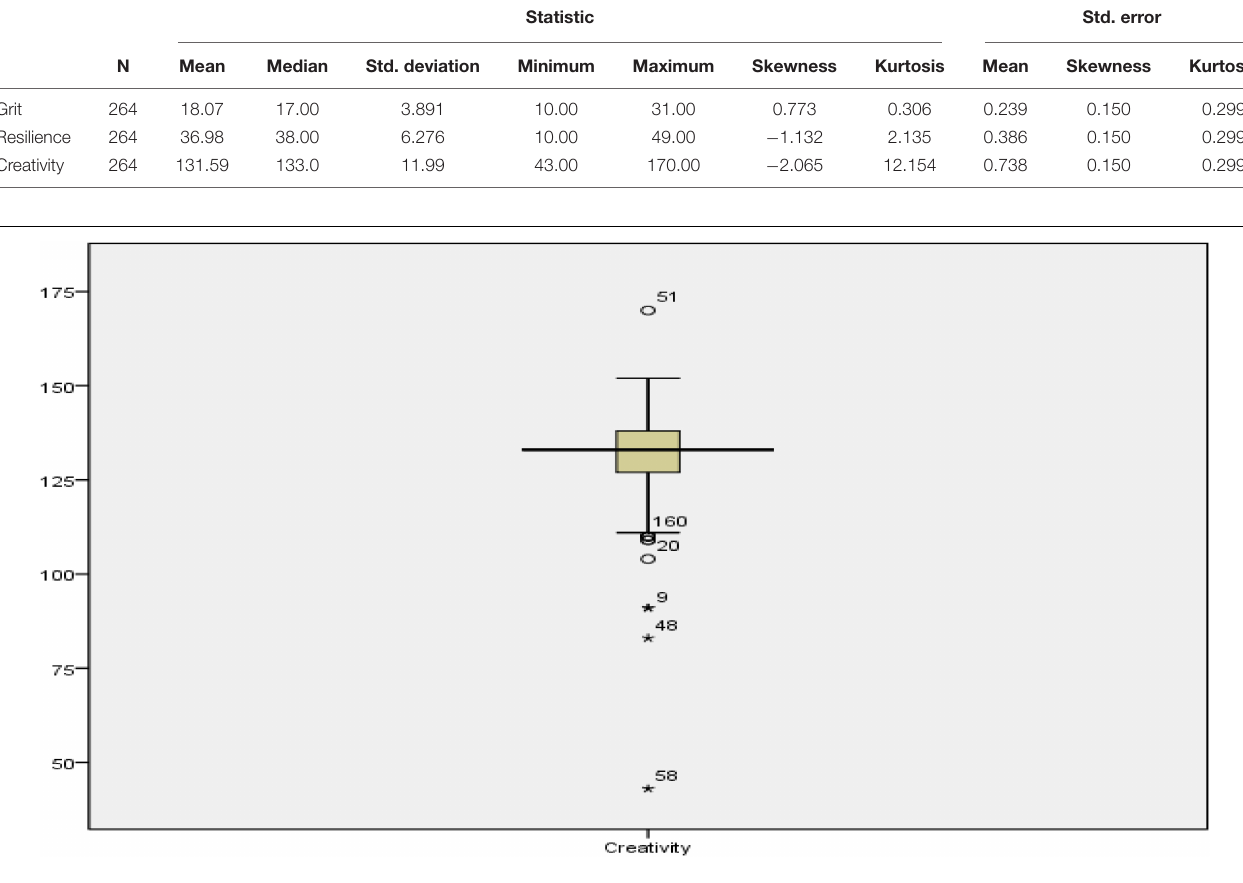
FIGURE 1 | The boxplot for creativity scores.